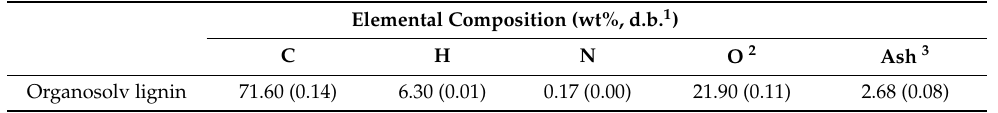
Table 1. Elemental composition of Alcell